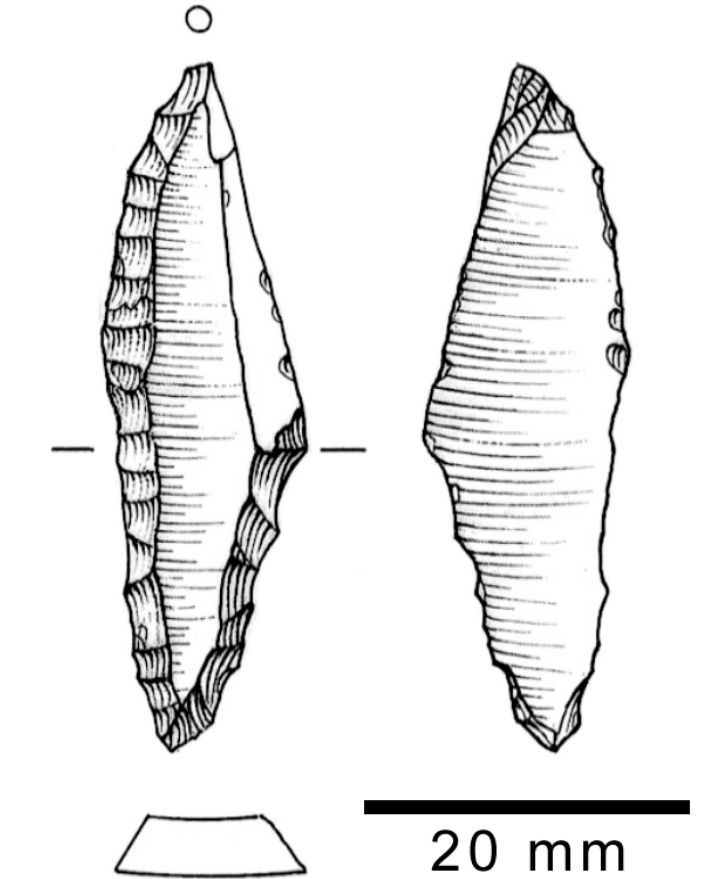
Figure 4. Dorsal and ventral view of the point (drawing: Marion Journal of Lithic Studies (2016) vol. 3, nr. 1, p. xx-xx doi:10.2218/jls.v3i1.1393